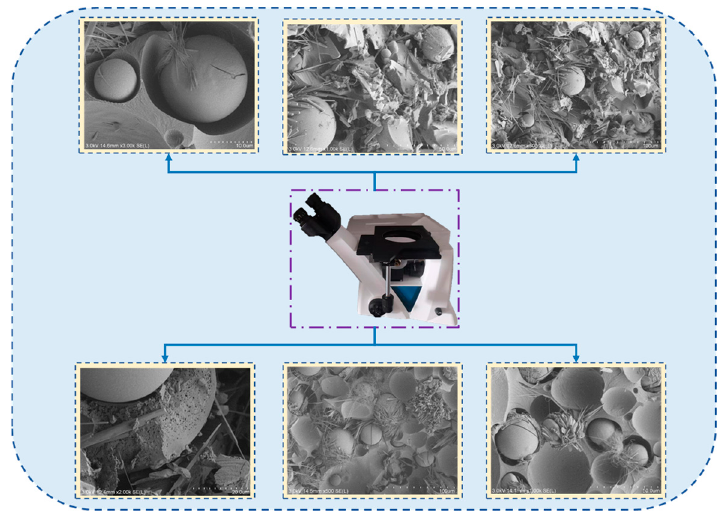
Figure 3. Images of new polyurethane composite materials under electron microscope.